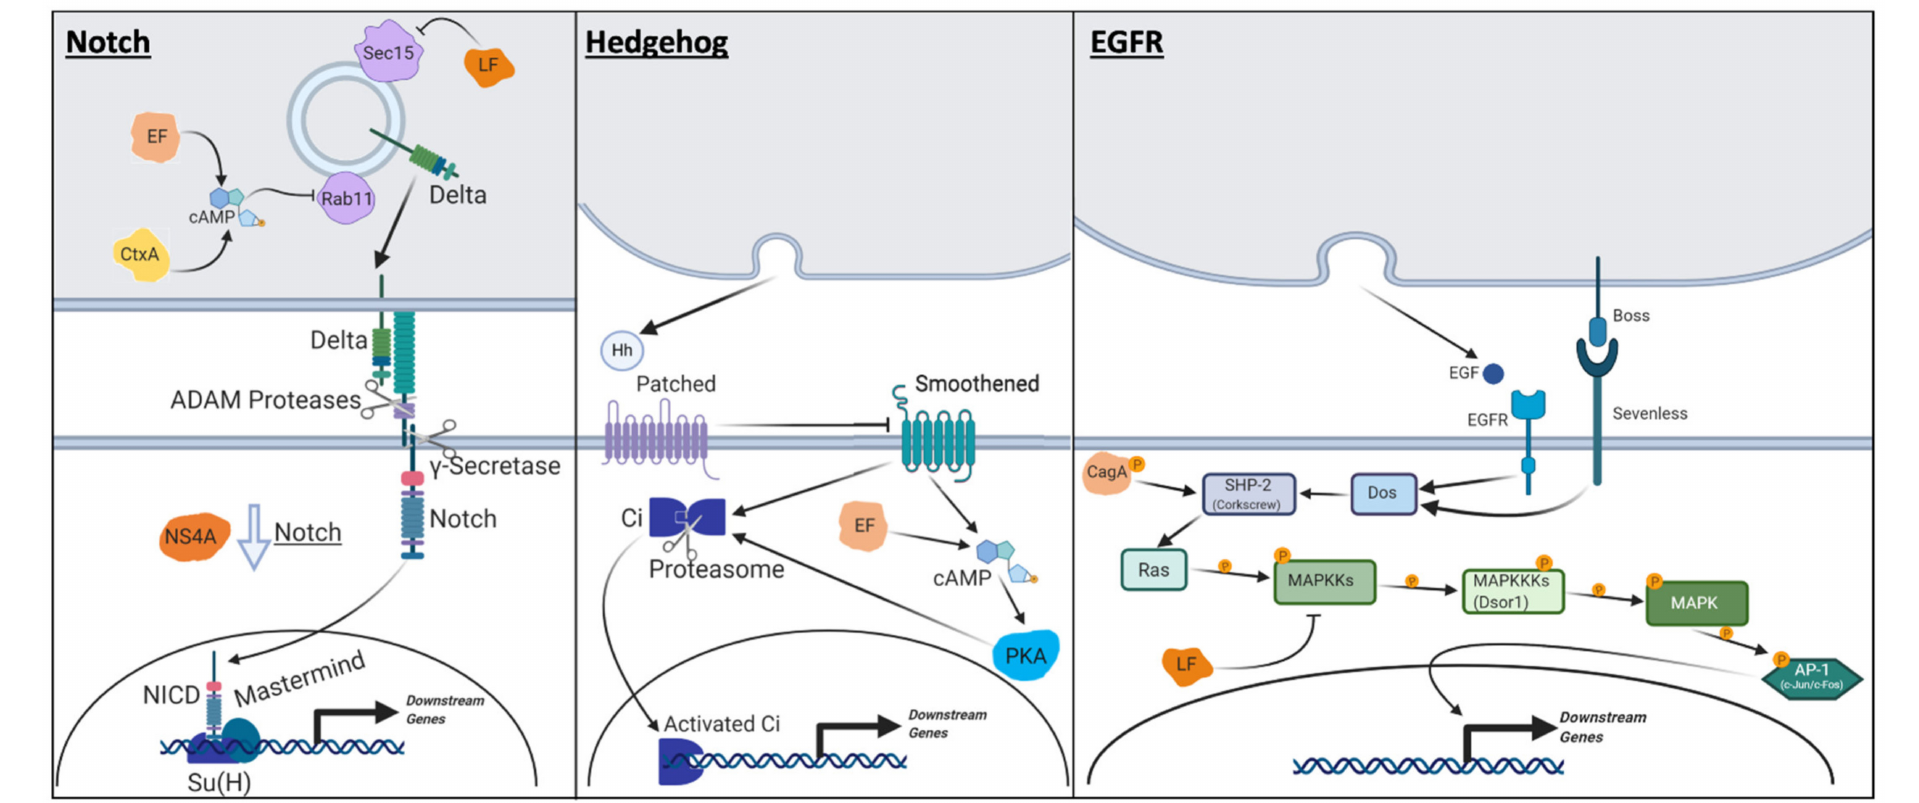
Figure 4. Virulence factors that affect developmental signaling pathways studied in Drosophila . Core components of the Notch ( left ), Hedgehog ( center ), and Ras-MAPK ( right ) pathways are depicted along with pathogenic proteins that target these pathways. Host proteins shown in cool colors and pathogenic proteins (CagA ( H. pylori ), CtxA ( Vibrio cholerae ), EF ( B. anthracis ), LF ( B. anthracis ), and NS4A (ZIKV)) are shown in warm